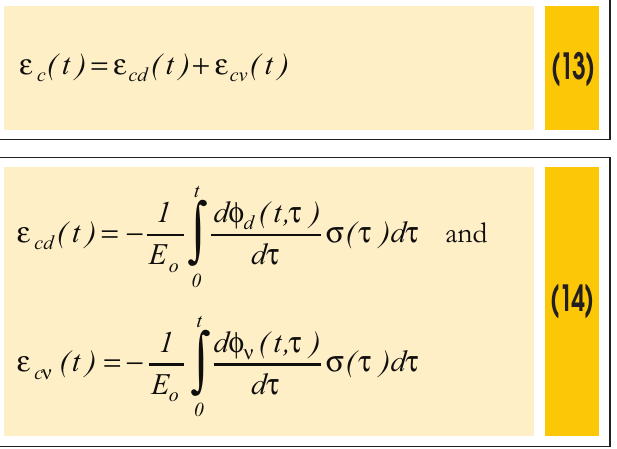
Figure 3 – Finite elements: a) Plane Q8; b) bar